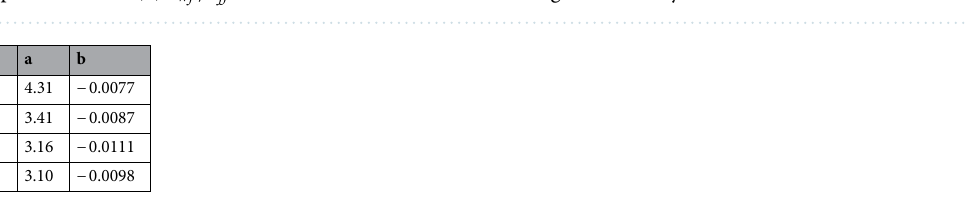
Figure 6. Diffusion coefficients (the component parallel to the walls) according to Eq. (9) versus ( a ) E z . Lines are power-law fits, ( b ) ε wf /ε ff , for the h = 6 nm channel. Lines are guide to the eye.